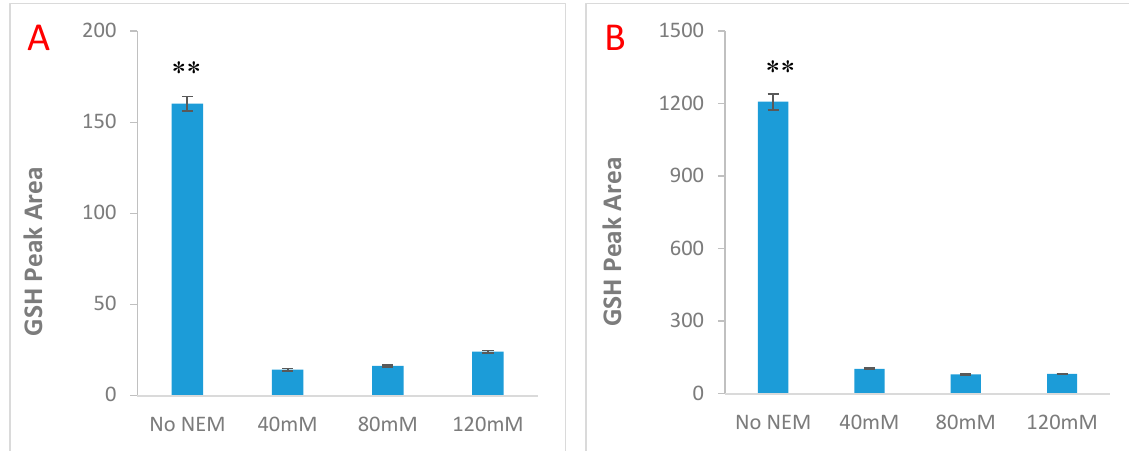
Figure 4. N-ethylmaleimide (NEM) optimisation using different amount of GSH ( A ) 200 µM ( B ) 2000 µM. The results also showed that 10–15% of GSH is oxidised to GSSG. Data are presented as mean ± SEM ( n = 5, ** p < 0.05).